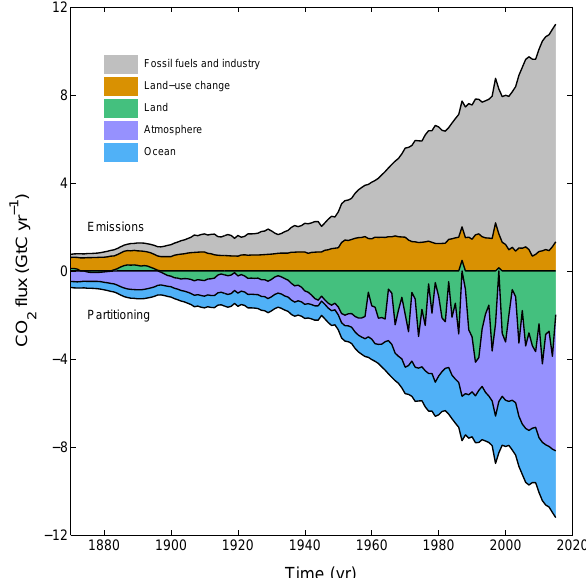
Figure 3. Combined components of the global carbon budget il- lustrated in Fig. 2 as a function of time, for emissions from fossil fuels and industry ( E FF ; grey) and emissions from land-use change ( E LUC ; brown), as well as their partitioning among the atmosphere ( G ATM ; purple), land ( S LAND ; green), and oceans ( S OCEAN ; dark blue). All time series are in GtCyr − 1 . G ATM and S OCEAN (and by construction also S LAND ) prior to 1959 are based on different meth- ods. The primary data sources for fossil fuels and industry are from Boden and Andres (2016), with uncertainty of about ± 5% ( ± 1 σ ); land-use-change emissions are from Houghton et al. (2012) with uncertainties of about ± 30%; growth rate in atmospheric CO 2 con- centration prior to 1959 is from Joos and Spahni (2008) with un- certainties of about ± 1–1.5GtCdecade − 1 or ± 0.1–0.15GtCyr − 1 (Bruno and Joos, 1997), and from Dlugokencky and Tans (2016) from 1959 with uncertainties of about ± 0.2 GtCyr − 1 ; the ocean sink prior to 1959 is from Khatiwala et al. (2013) with uncertainty of about ± 30%, and from this study from 1959 with uncertainties of about ± 0.5GtCyr − 1 ; and the residual land sink is obtained by difference (Eq. 8), resulting in uncertainties of about ± 50% prior to 1959 and ± 0.8GtCyr − 1 after that. See the text for more details of each component and their uncertainties.